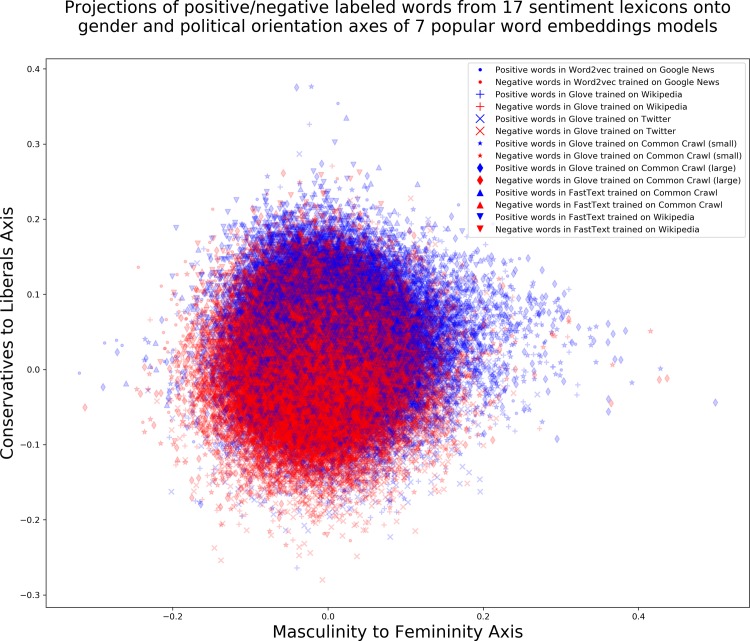
Associations of externally annotated positive/negative terms (N = 15635; negative = 9181) from 17 sentiment lexicons with gender and political orientation cultural axes derived from 7 popular word embedding models.Blue color denotes a positive word and red color denotes a negative word.